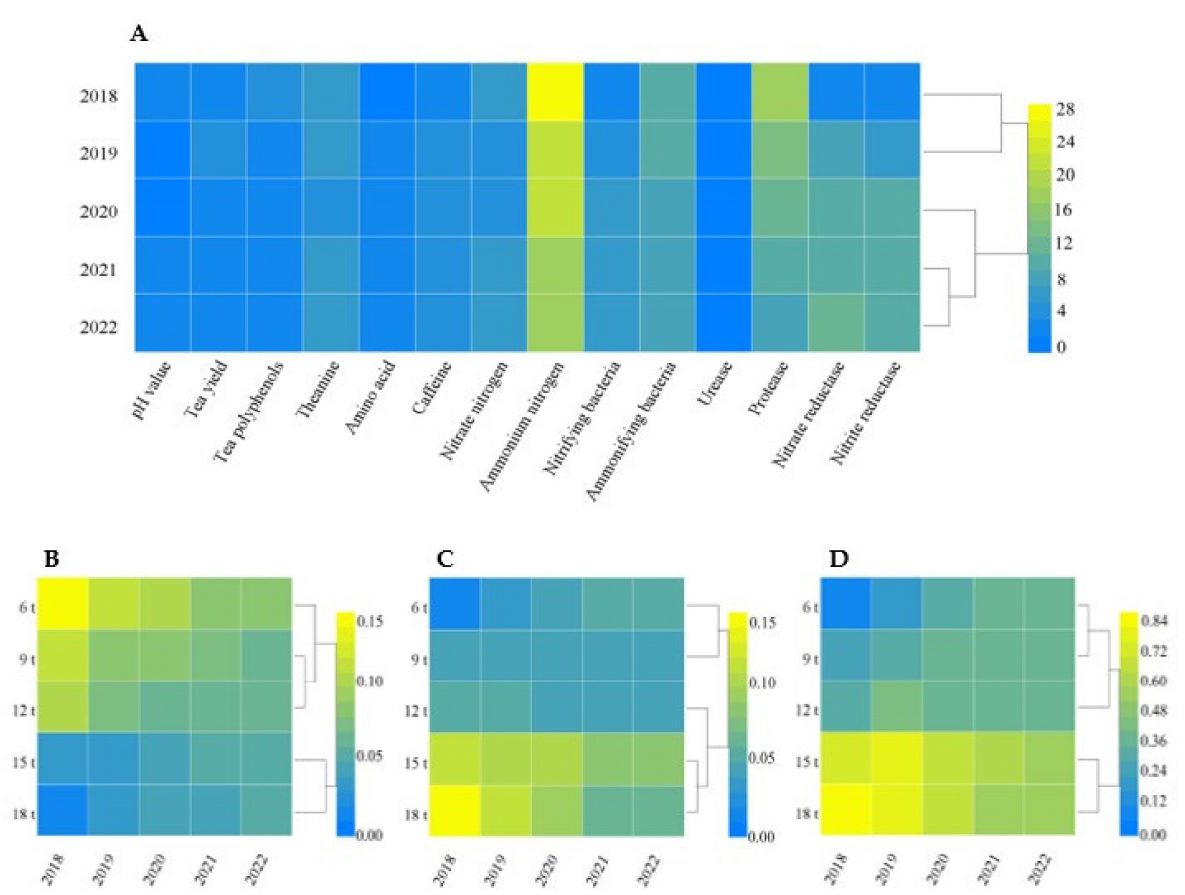
Figure 11. Topsis analysis of comprehensive evaluation of soil and tea tree indexes after long-term use of sheep manure with different dosages. ( A ) Weight of soil and tea tree indicators under different dosages of sheep manure treatment from 2018 to 2022; ( B ) distance synthesis values of positive ideal solutions (D + ) for each index under different dosages of sheep manure treatment from 2018 to 2022; ( C ) distance synthesis values of negative ideal solutions (D − ) for each index under different dosages of sheep manure treatment from 2018 to 2022; ( D ) relative proximity between the fertilization effect and the optimal scheme after different sheep manure treatments in